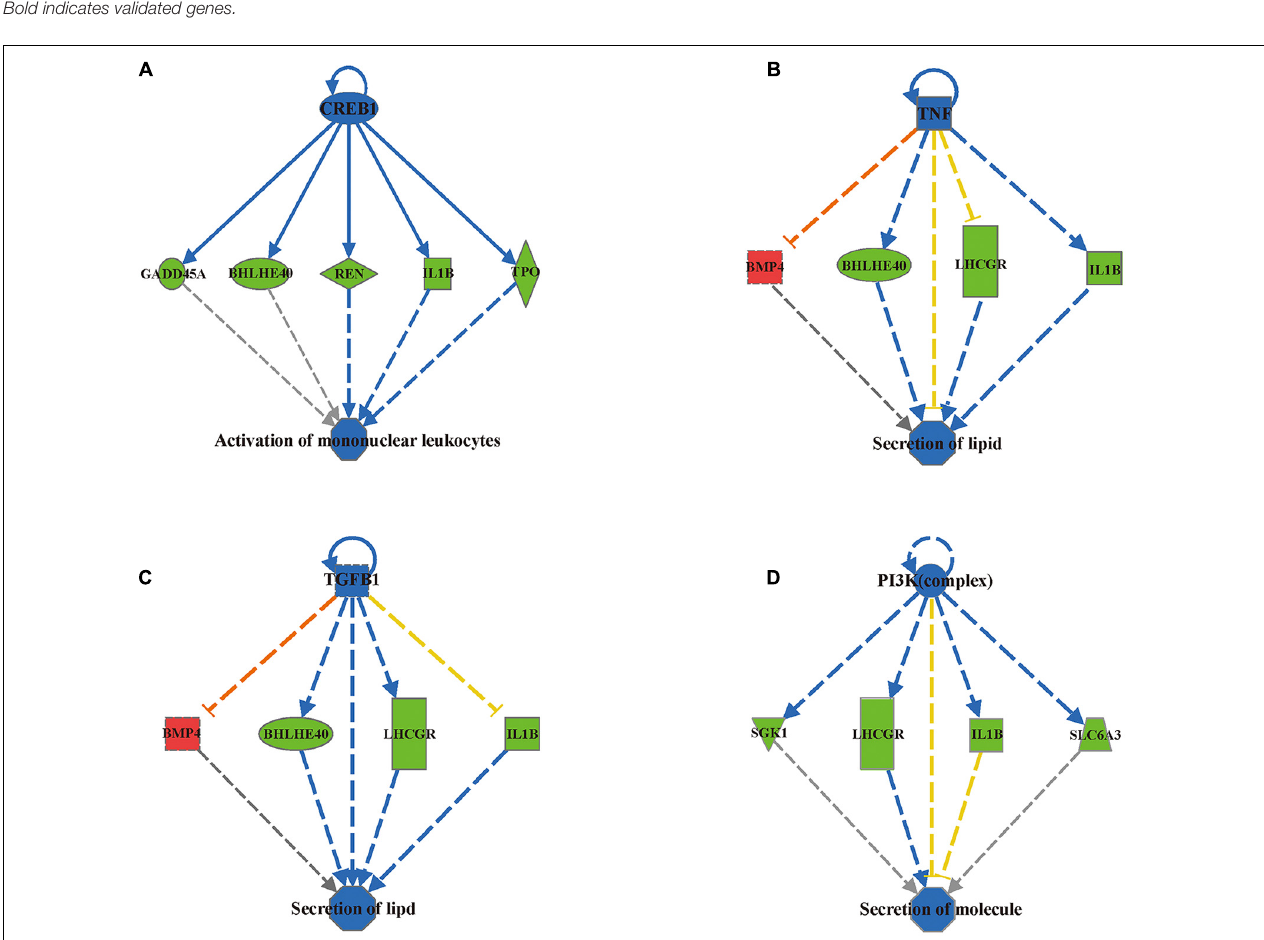
FIGURE 6 | IPA predicted 4 novel regulation networks ranked by consistency score. The first layer of the network is an upstream regulatory factor, the middle layer is the differentially methylated genes uploaded from the IPA database, and the bottom layer is the related biological functions. Blue nodes indicate that the upstream regulatory factor’s function is predicted inhibition. Blue solid lines indicate a confirmed direct inhibition, while blue dashed lines indicate indirect inhibition. Red dashed lines indicate indirect activation. Yellow dashed lines indicate findings inconsistent with the state of the downstream molecule. Green nodes indicate downregulation of the expression levels of the genes and Red nodes indicate upregulation. (A) CREB1 regulation network. (B) TNF regulation network. (C) TGFB1 regulation network. (D) PI3K (complex) regulation network.